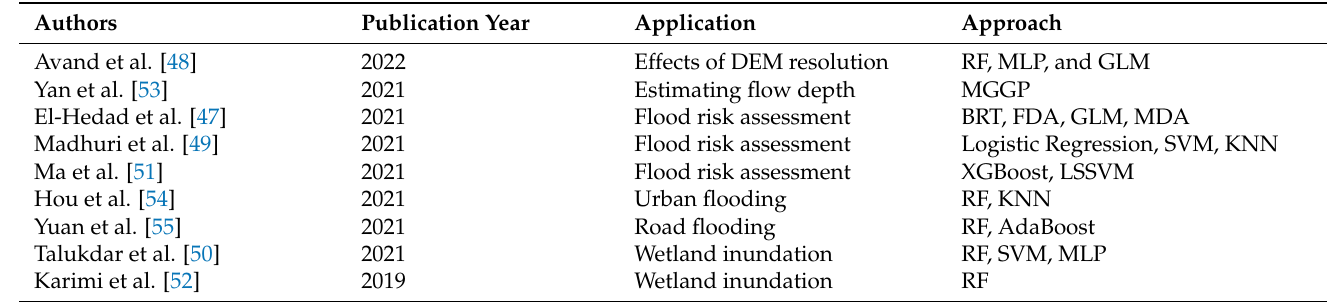
Table 2. Summary of traditional ML approaches for inundation